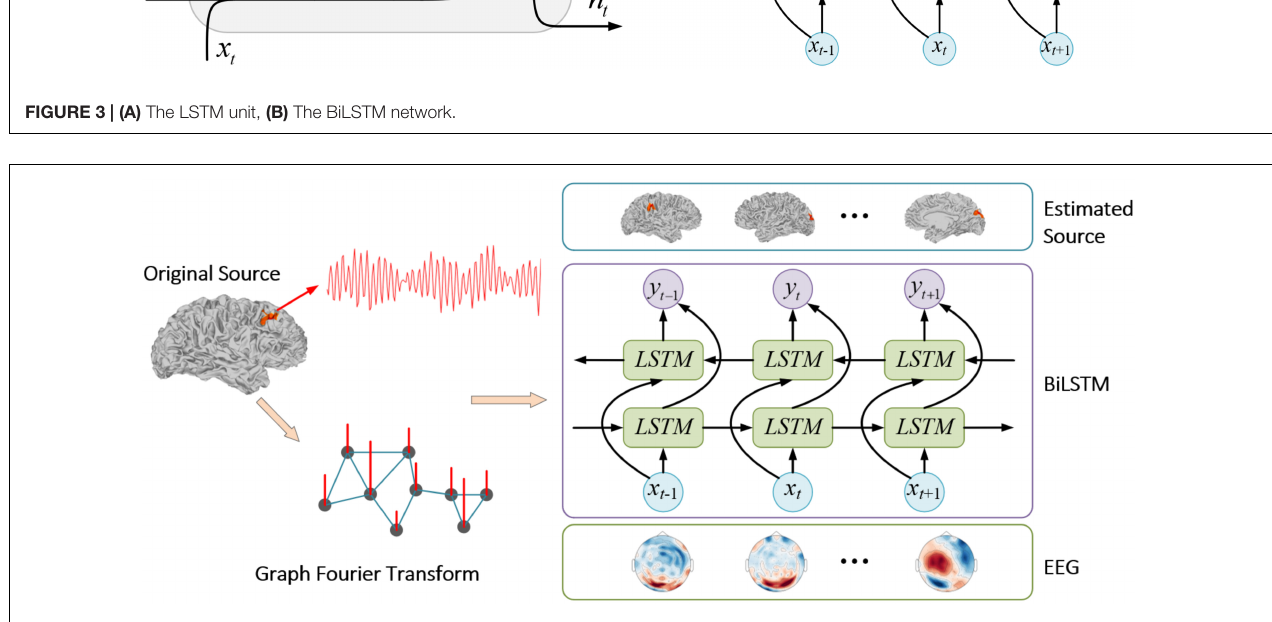
FIGURE 4 | The flowchart for the proposed method.